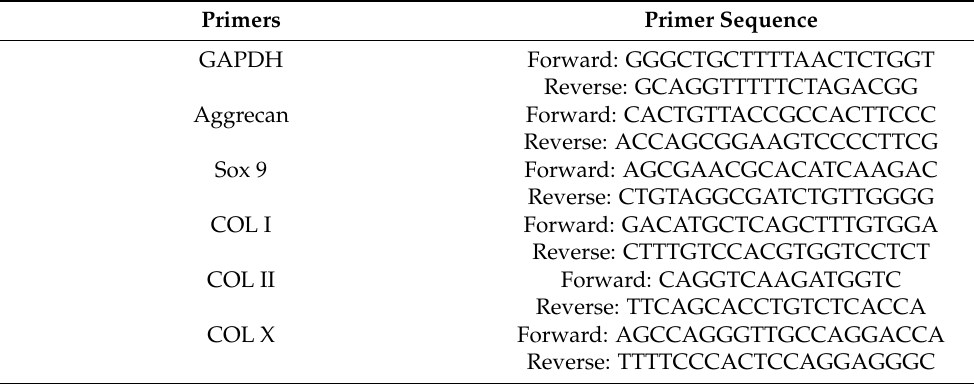
Table 1. Details of the primer